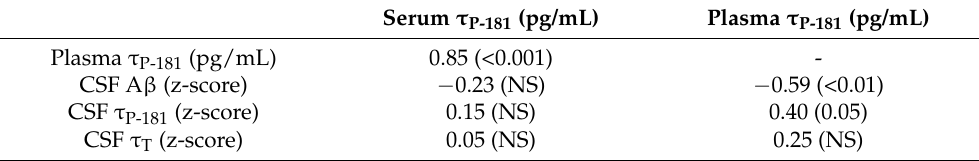
Table 3. Correlation of serum and plasma levels of pT181-Tau with the other biomarkers.